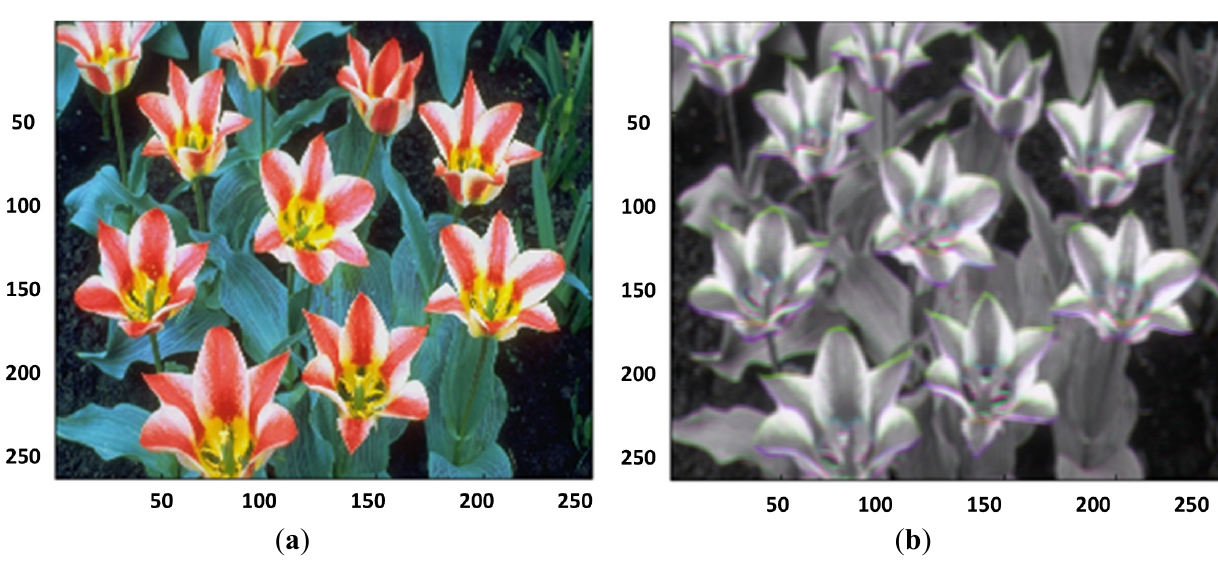
Figure 7. ( a ) Original tulip image and ( b ) Tulip image after rotor